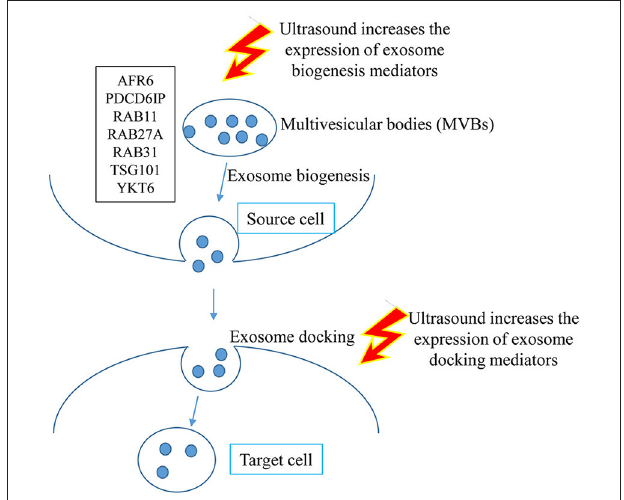
FIGURE 4 | Graphical representation of the hypothesis that LIUS may increase exosome biogenesis and docking in the tissues exposed to ultrasound therapy.